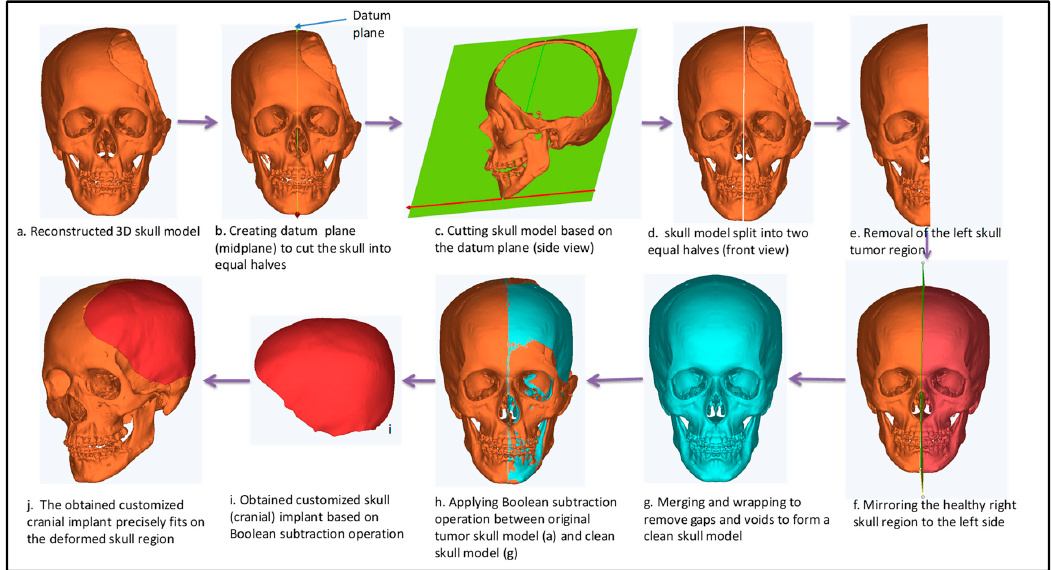
Figure 3. Steps involved in the design of customized cranial implant in 3-Matic ® : ( a ) Reconstruction of 3D skull model; ( b ) Generation of midplane; ( c ) Cutting of skull model; ( d ) Splitted model; ( e ) Removal of defected side; ( f ) Mirroring of right side; ( g ) Merging of two sides; ( h ) Application of Boolean subtraction; ( i ) Customized implant; ( j ) Skull with fitted Implant.